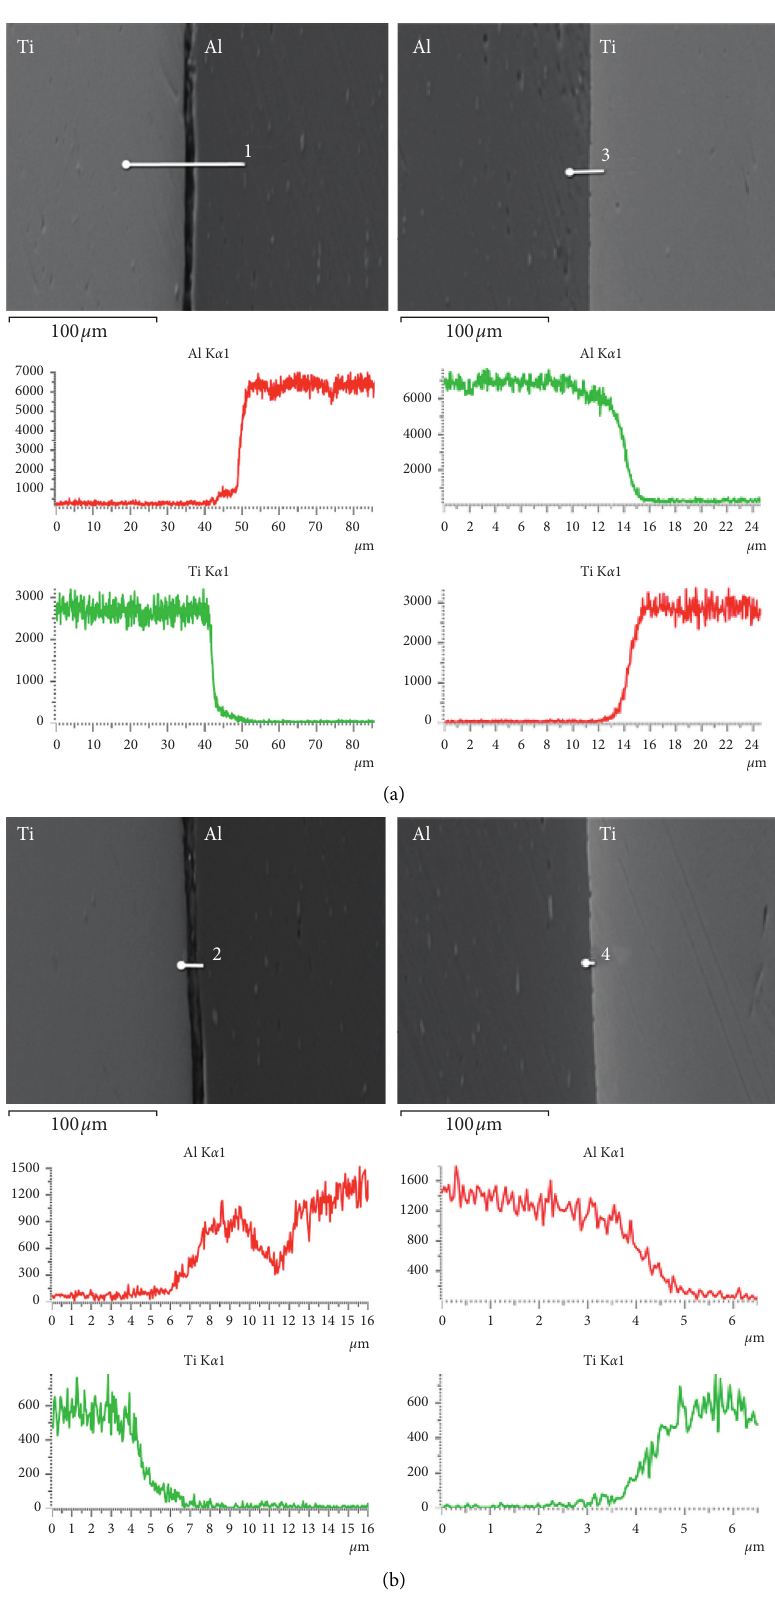
Figure 11: The morphology and energy spectrum of (a) S1 and (b)